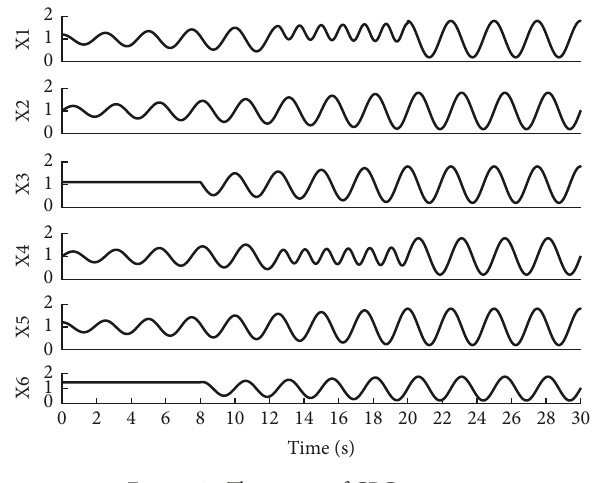
Figure 17: The output of CPG neurons.